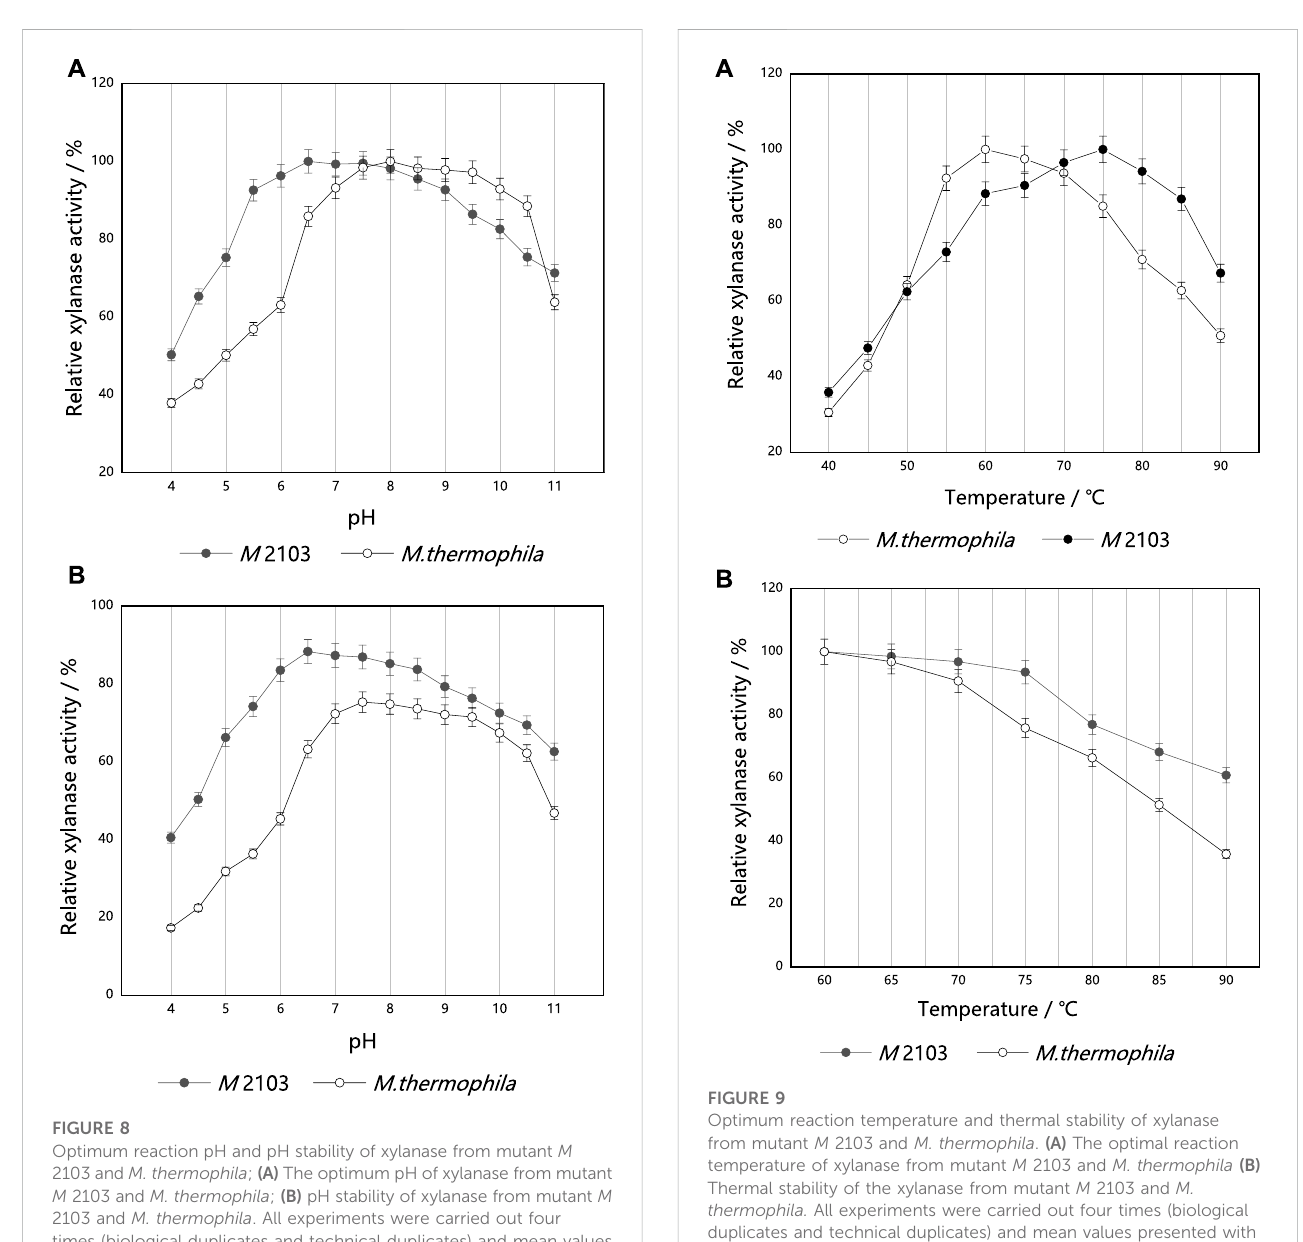
2103 could be maintained above 65%. Compared with the alkaline condition, the xylanase activity of M 2103 in the acidic range was higher and relatively stable.